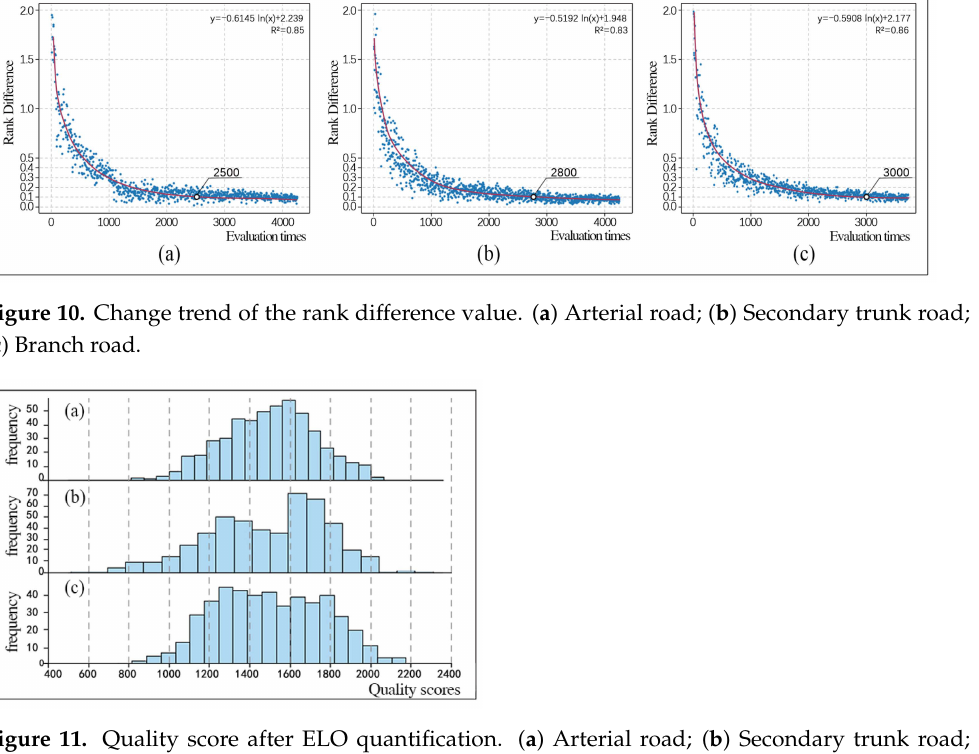
Figure 11. Quality score after ELO quantification. ( a ) Arterial road; ( b ) Secondary trunk road; ( c ) Branch road.